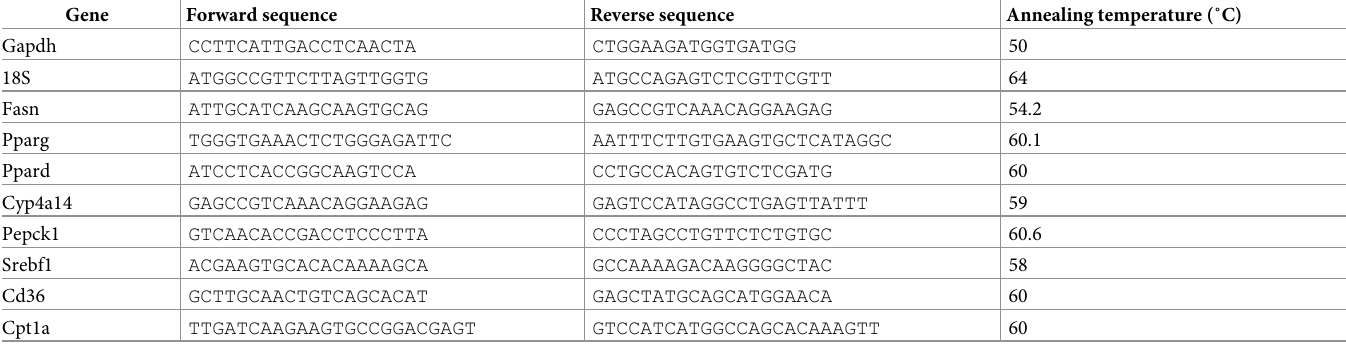
Table 1. Primer sequences for determining hepatic gene expression of insulin, Srebf, and Ppar regulated genes involved in lipid uptake, storage, and metabolism. Gene Forward